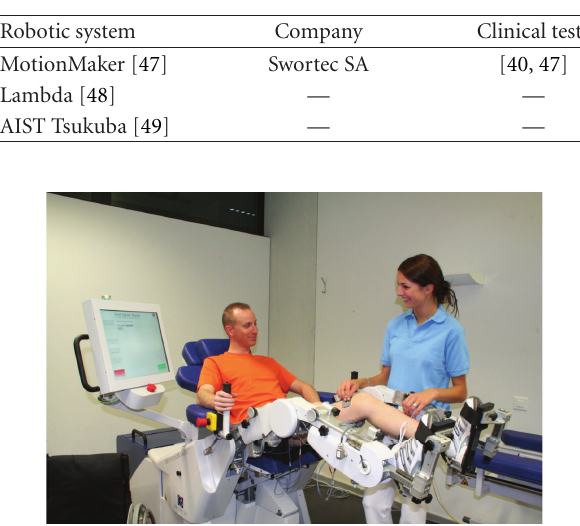
Figure 10: The MotionMaker rehabilitation system (Picture cour- tesy of Swortec SA).